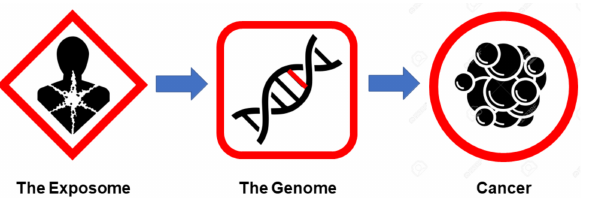
Figure 1. A simplified depiction of how the somatic mutation theory (SMT) and the genomic view of cancer explain oncogenesis. Environmental exposures (the exposome) lead to mutations in the genome which lead to tumor